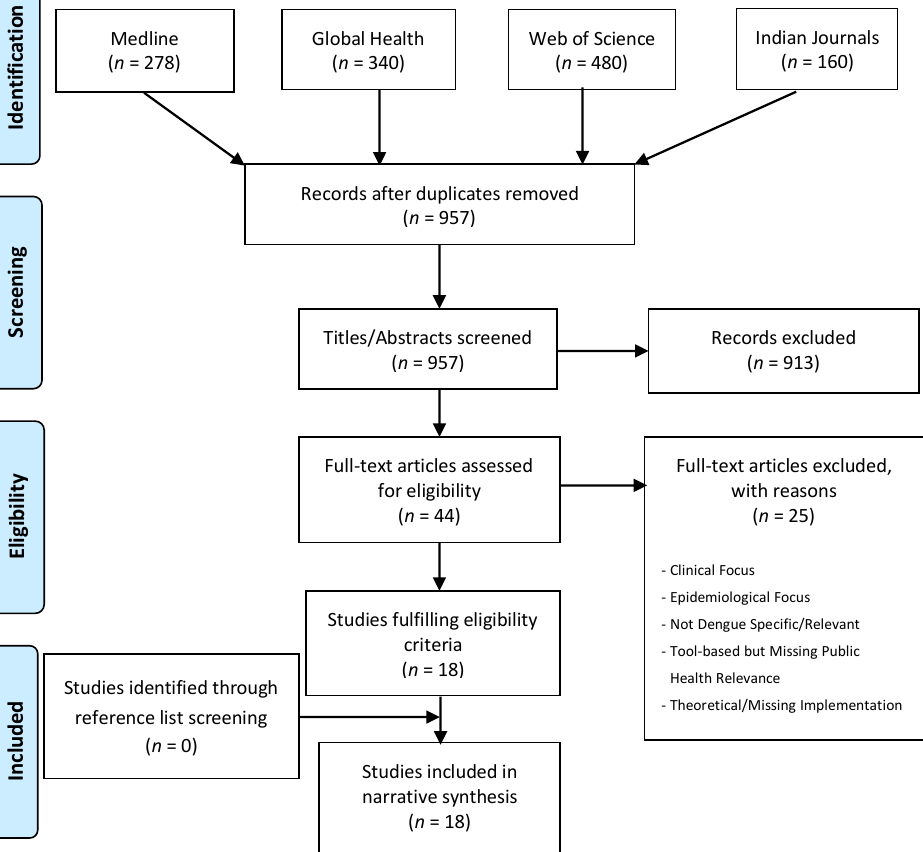
Figure 1. Systematic literature review PRISMA flow diagram.